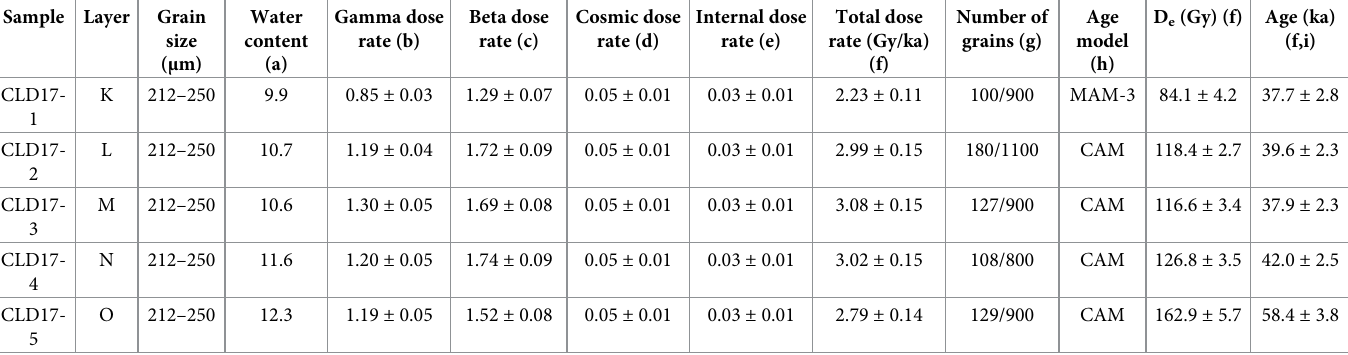
Table 6. Single-grain OSL dating results. Sample